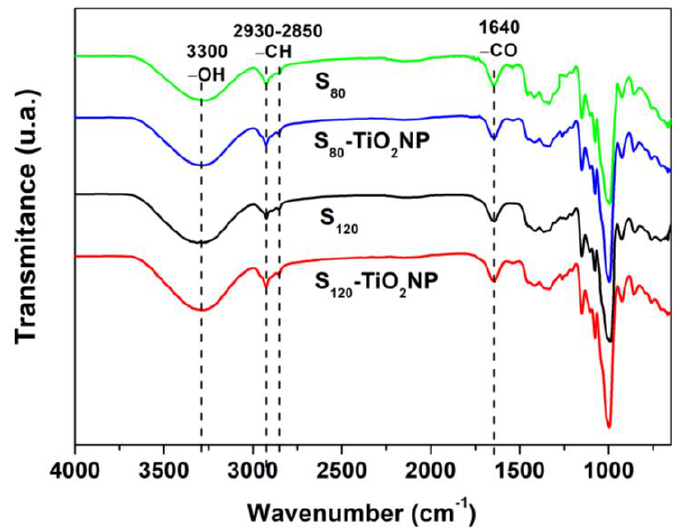
Figure 2. FTIR spectrum of the different studied films.